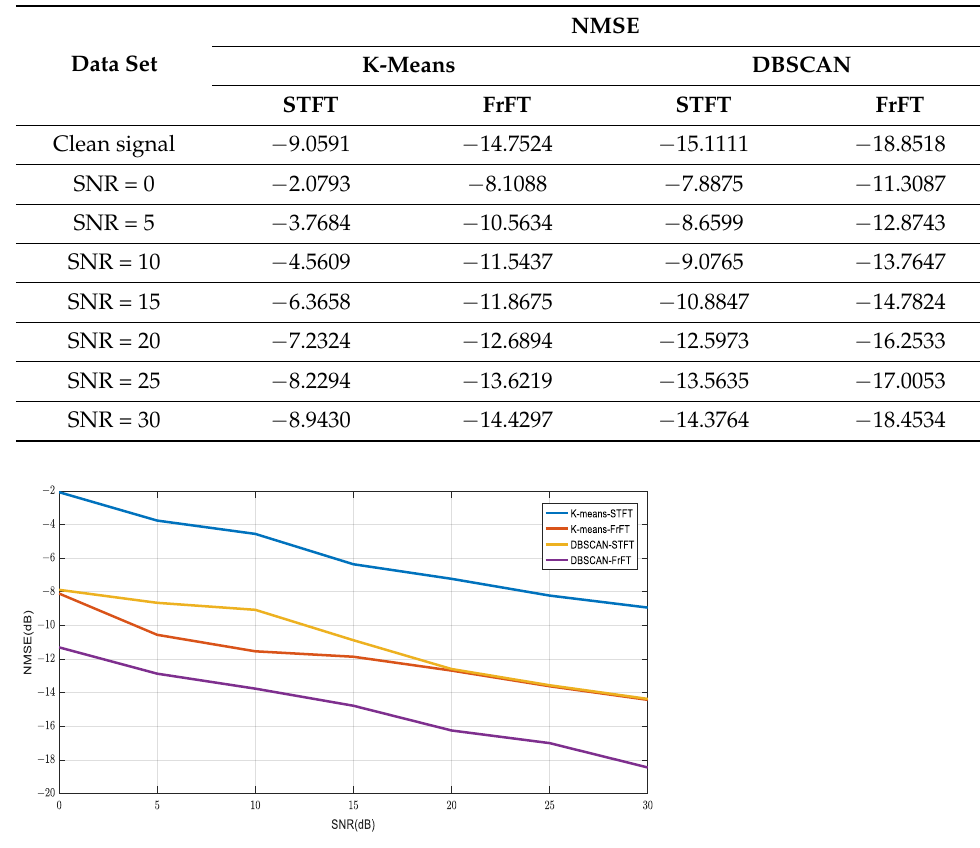
Table 4. Comparison of estimation accuracy of mixed matrix obtained by different clustering algo- rithms (30 times).